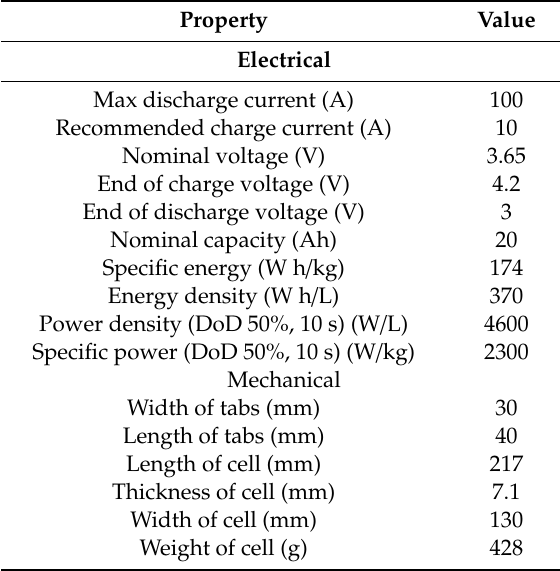
Table A1. Characteristics of NMC